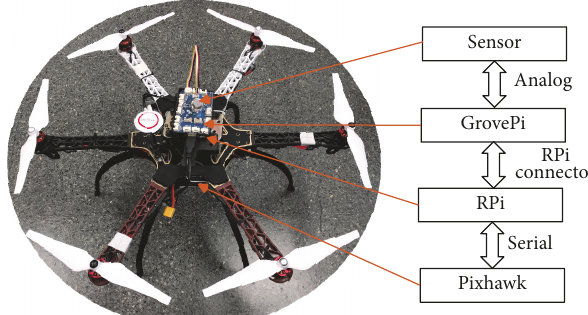
Figure 1: Proposed UAV with air pollution